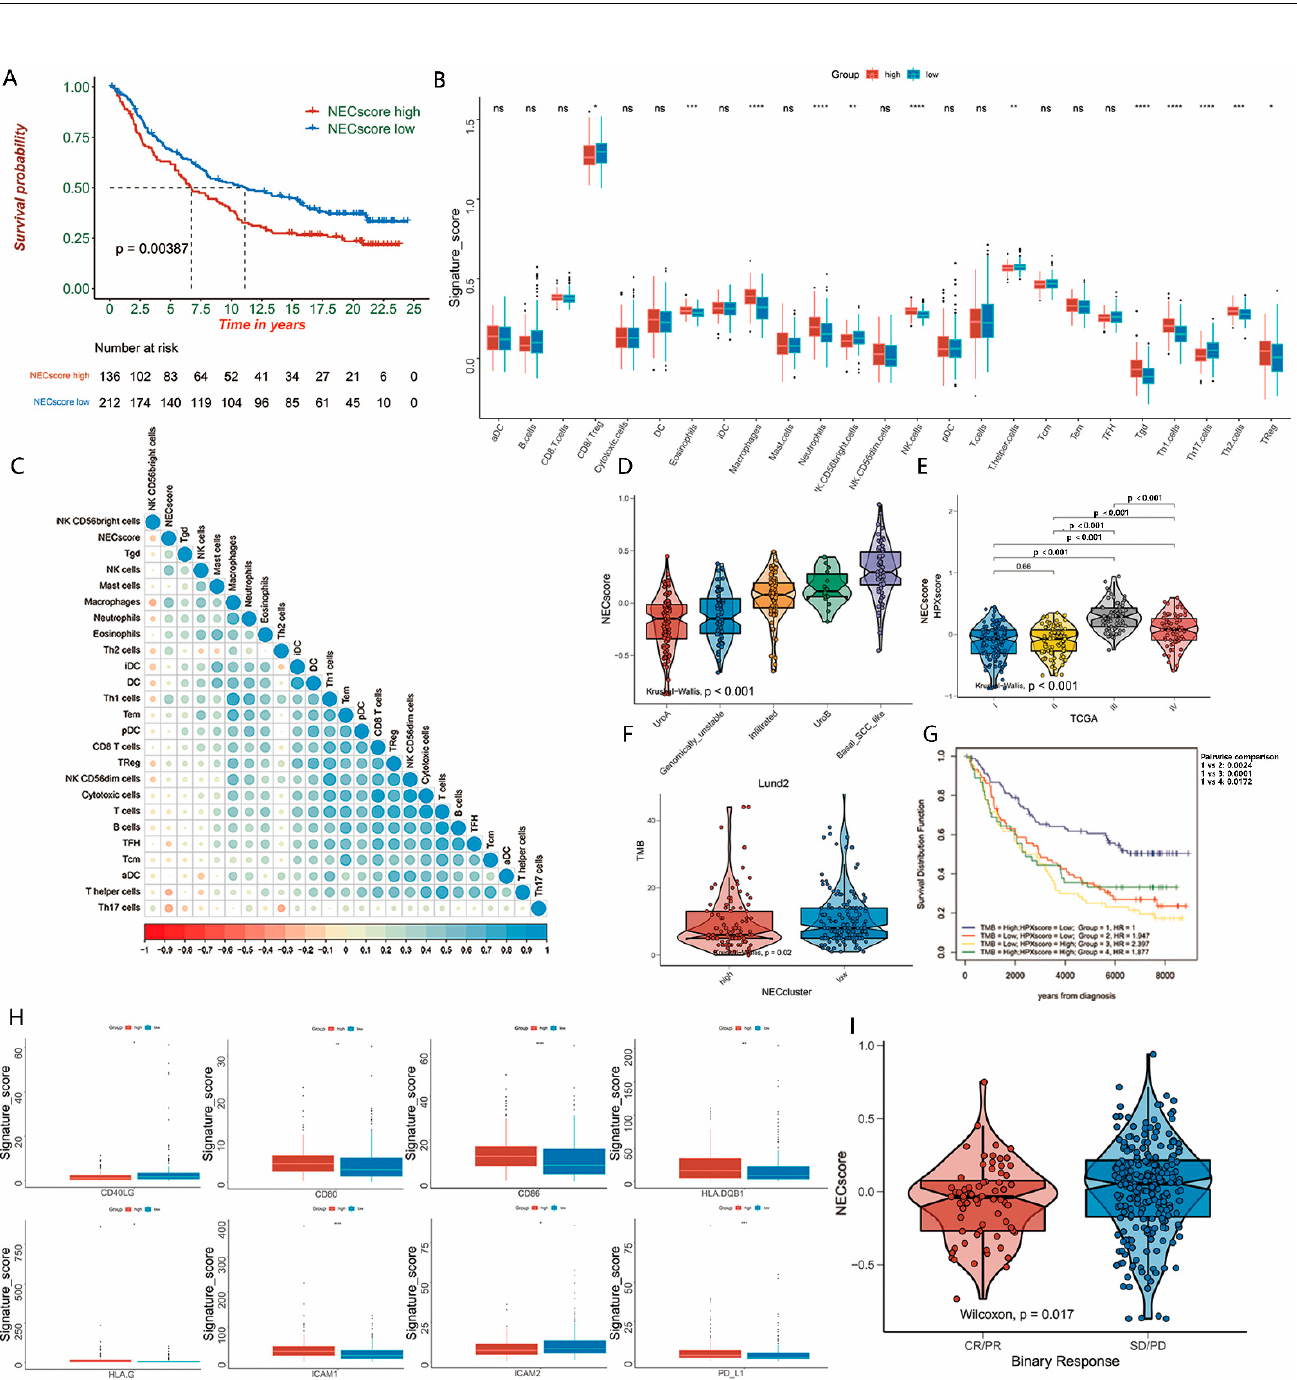
Figure 5. Characteristics of NEC score in IMvigor210 (mUC) cohort. ( A ) Kaplan–Meier survival curves show the difference in prognosis advantage between high and low NEC score groups in the IMvigor210 (mUC) cohort (log-rank test, p = 0.00387). ( B ) Difference in the enrichment of the indicated gene signature between high and low NEC score groups in the IMvigor210 (mUC) cohort. The upper and lower ends of the boxes represent the interquartile range of values. The lines in the boxes represent median value, and the black dots show outliers. The statistical difference between high and low NEC score groups was tested by the Student’s t test. ns non-significant, * p < 0.05, ** p < 0.01, *** p < 0.001, **** p < 0.0001. ( C ) Correlation between NEC score and indicated gene signature in IMvigor210 (mUC) cohort. Blue indicates negative correlation and red indicates positive correlation. ( D ) Differences in NEC score among different molecular subtypes in the Lund classification system in IMvigor210 (mUC) cohort. The Kruskal–Wallis test was used to compare the statistical difference between different molecular subtypes ( p < 0.00001). ( E ) Differences in NEC score among different